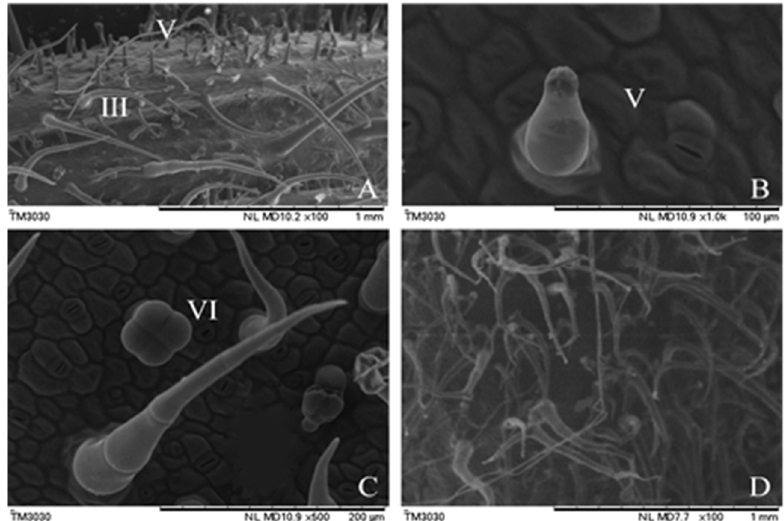
Figure 3. Morphological observation of different types of trichomes of tomato 3-071 (tomato ln mutant , hairless) under a scanning electron microscope. The gross state of the 3-071 accession was observed by scanning electron microscopy, and different types of trichomes are marked in the picture. Scale bars ( A ) =1 mm, ( B ) = 100 μ m, ( C ) = 200 μ m, ( D ) = 1 mm.